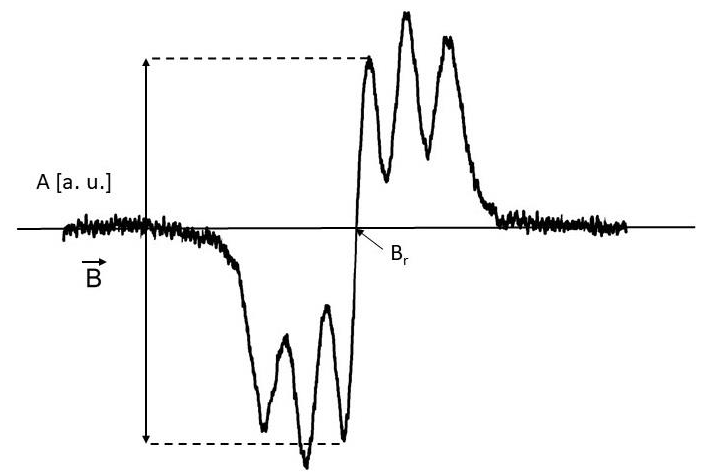
Figure 13. The exemplary EPR spectrum of DPPH free radicals in ethyl alcohol solution. A—ampli- tude of the EPR lines, B—magnetic induction, B r —resonance magnetic induction. amplitude of the EPR lines, B—magnetic induction, B r —resonance magnetic